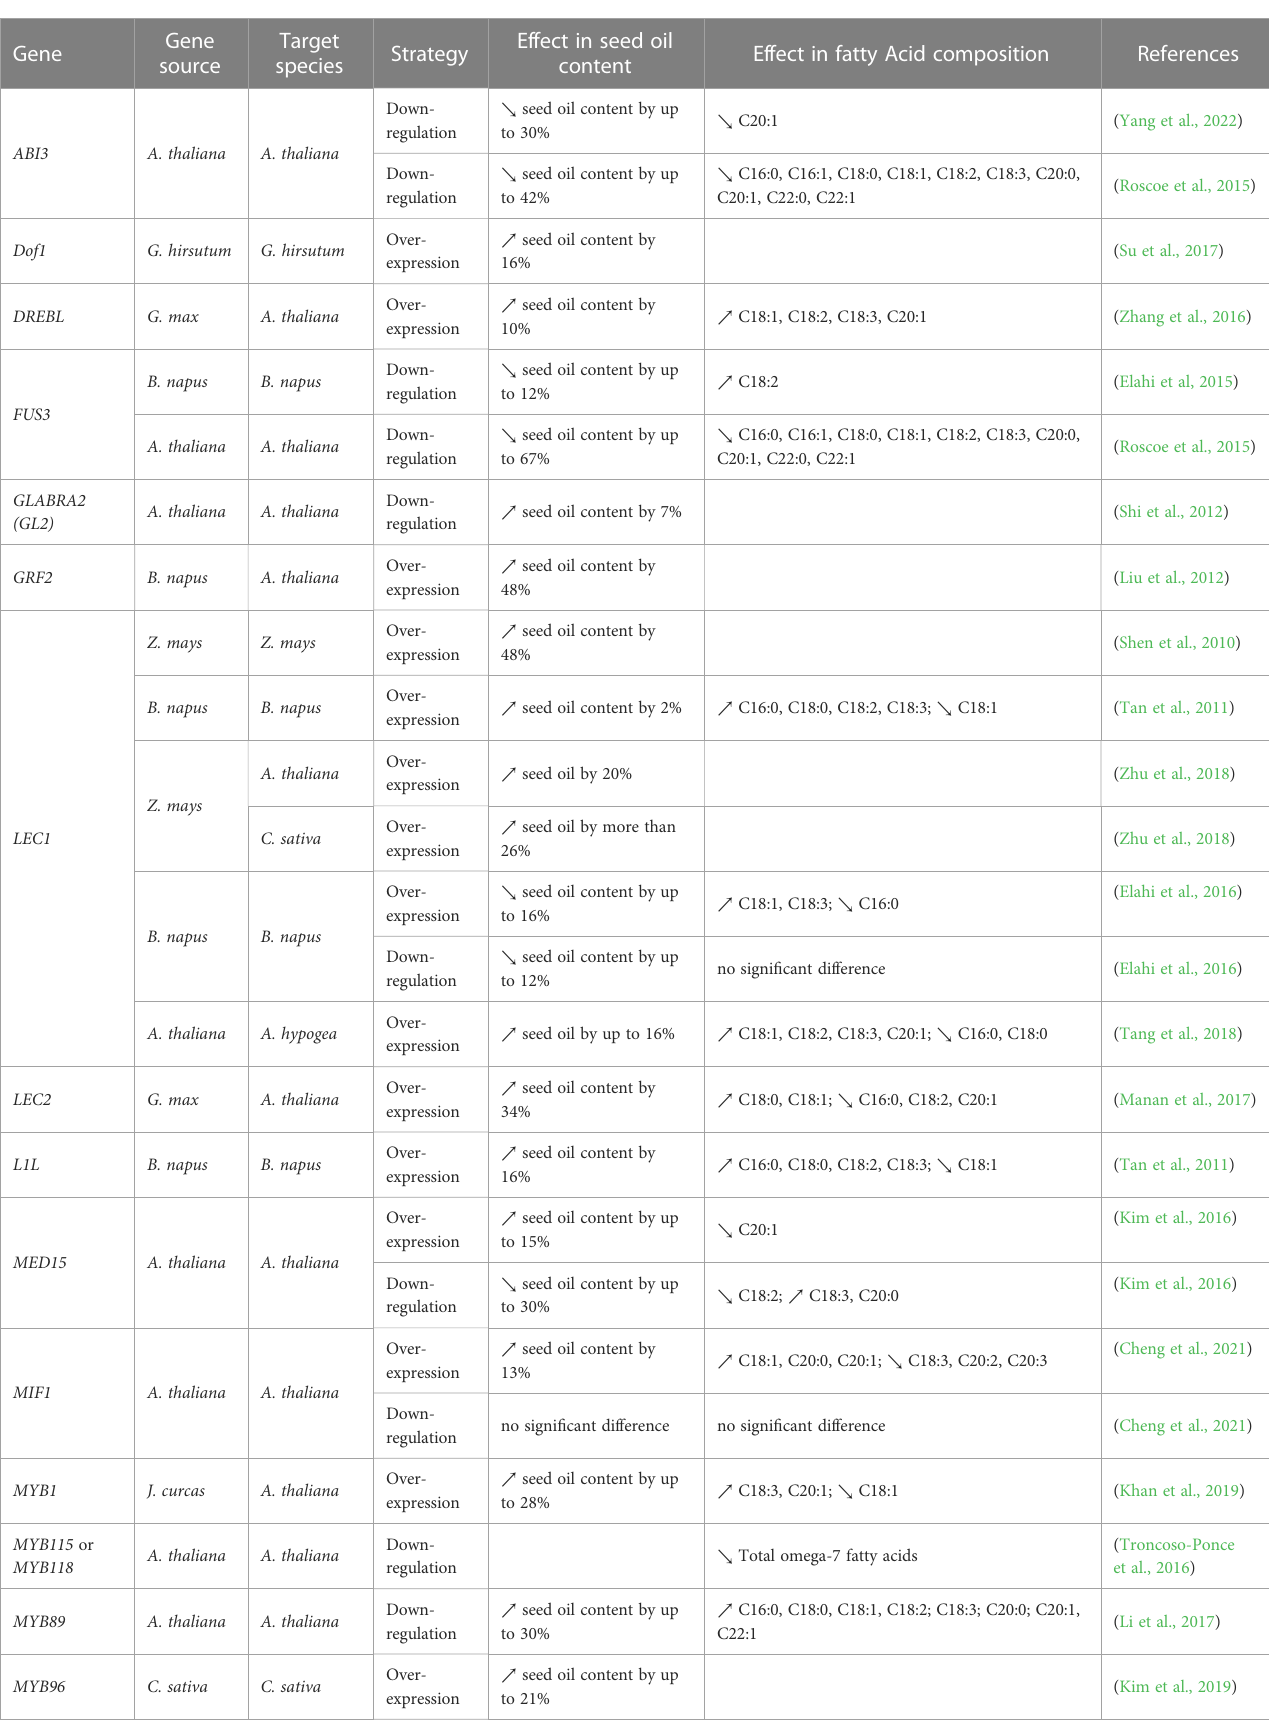
TABLE 3 List of genes encoding TFs manipulated to enhance oil yield and/or change the FA composition in seeds.